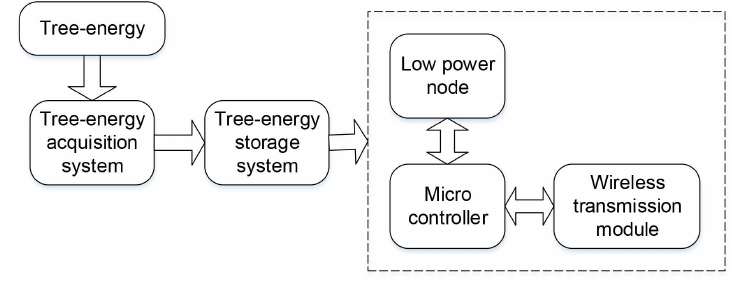
Figure 3. Wireless sensor powered by tree.